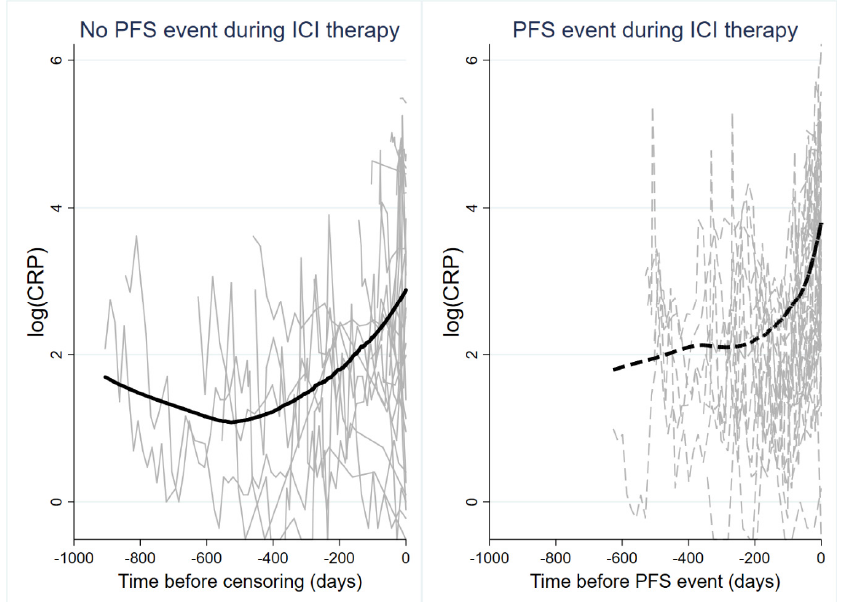
Figure 4. Line plot of CRP trajectories in patients who did (right panel, gray dashed lines) and did not (left panel, gray solid lines) develop a PFS event during ICI therapy. Each line represents the log(CRP) trajectory of a single patient. The bold solid line (left panel) and bold dashed line (right panel) represent moving averages (locally weighted sum-of-squares (LOWESS) nonparametric smoother). Note that the time on the x-axis of both panels is inverted, i.e., it represents the time before a PFS event or censoring without a PFS event. Abbreviations: PFS—progression-free survival; ICI—immune checkpoint inhibitor.